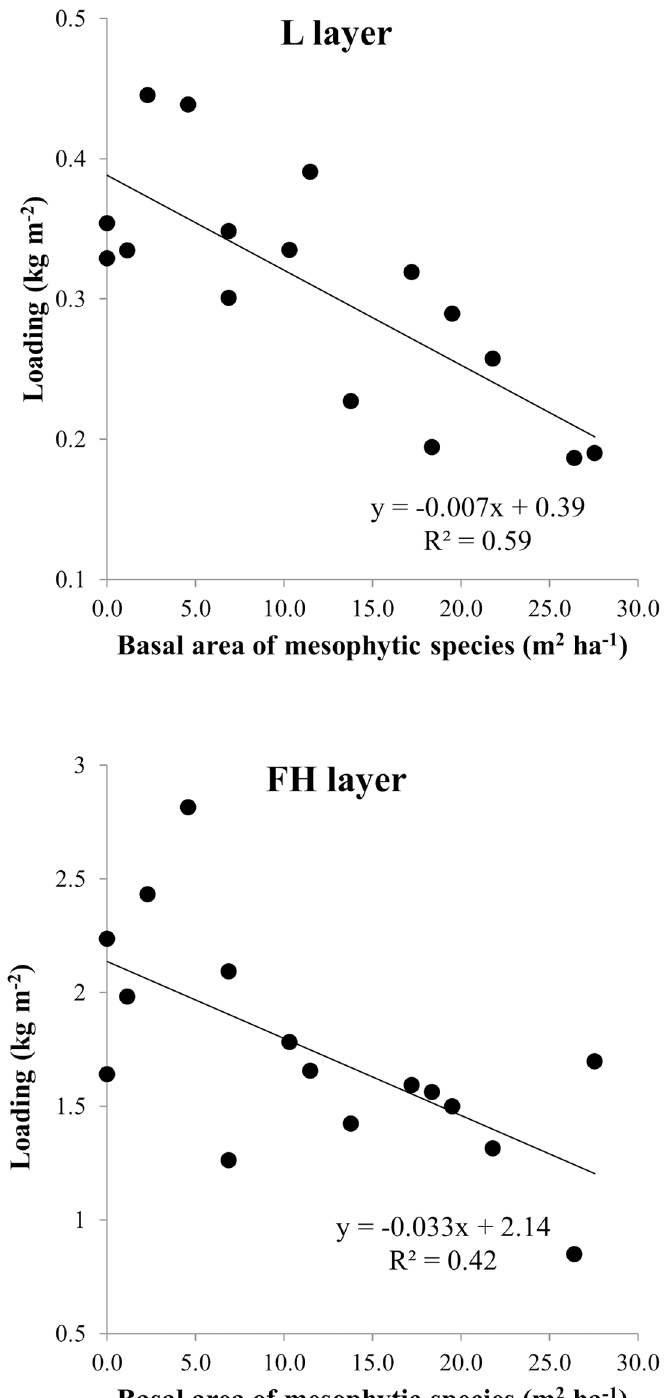
Fig 6. In-situ fuel bed characteristics in relation to overstory composition. Linear regression between the loading of L and FH layers for in-situ beds and the basal area of stems around common gardens that were mesophytic. In-situ beds were not manipulated in any way and were sampled adjacent to common gardens. Oak and hickory and mesophytic stems made up > 90% of the species composition of common gardens (Table 2). As such, plots of loading as a function of oak and hickory relative abundances yield relationships that are nearly the inverse of those shown